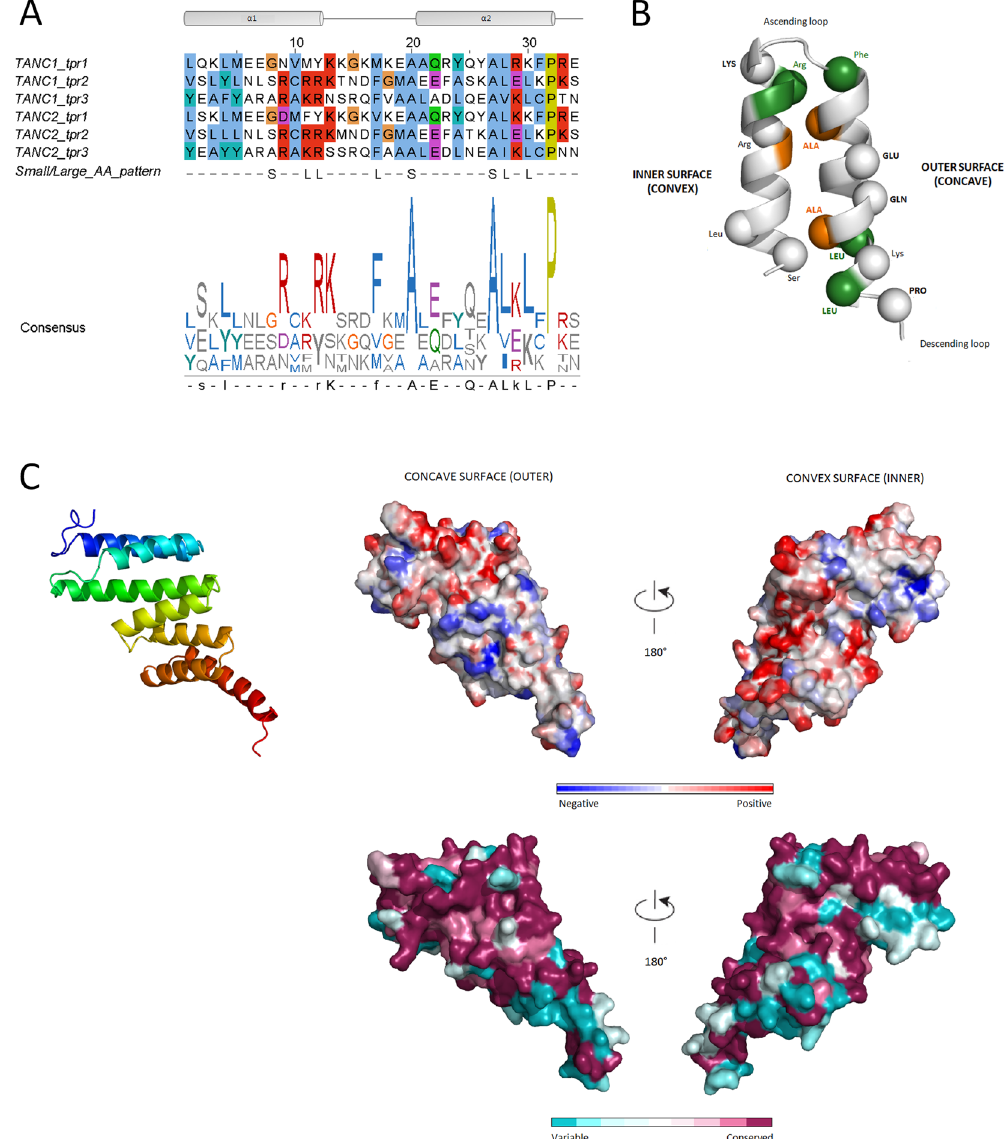
Figure 5. TPR repeat overview and TANC2 TPR model. ( A) Consensus sequence repeat pattern of the TANC TPR domain and related sequence logo. Secondary structure is shown above the alignment: two alpha helices (grey shapes) connected by a loop (black line). Below the alignment, pattern of conserved small/large residues typical of TPR modules is reported: S indicates small residues, L for large residues. Residues that match the consensus are reported in upper case. ( B) Graphic representation of repeats structure in TANC proteins. Conserved positions of TPR consensus pattern are reported in the diagram (spheres). Residues that match the consensus are reported in bold. Conserved small-large residue pattern is also represented: dark green for large residues and orange for small residues. ( C) Cartoon of TANC2 TPR domain model is coloured from N-terminus (blue) to C-terminus (red). Electrostatic properties of concave and convex surfaces are shown: negative charges in blue and red charges in red. ConSurf analysis of turn-loop surfaces and connecting-loop surfaces, colour code from unconserved (cyan) to conserved (purple)